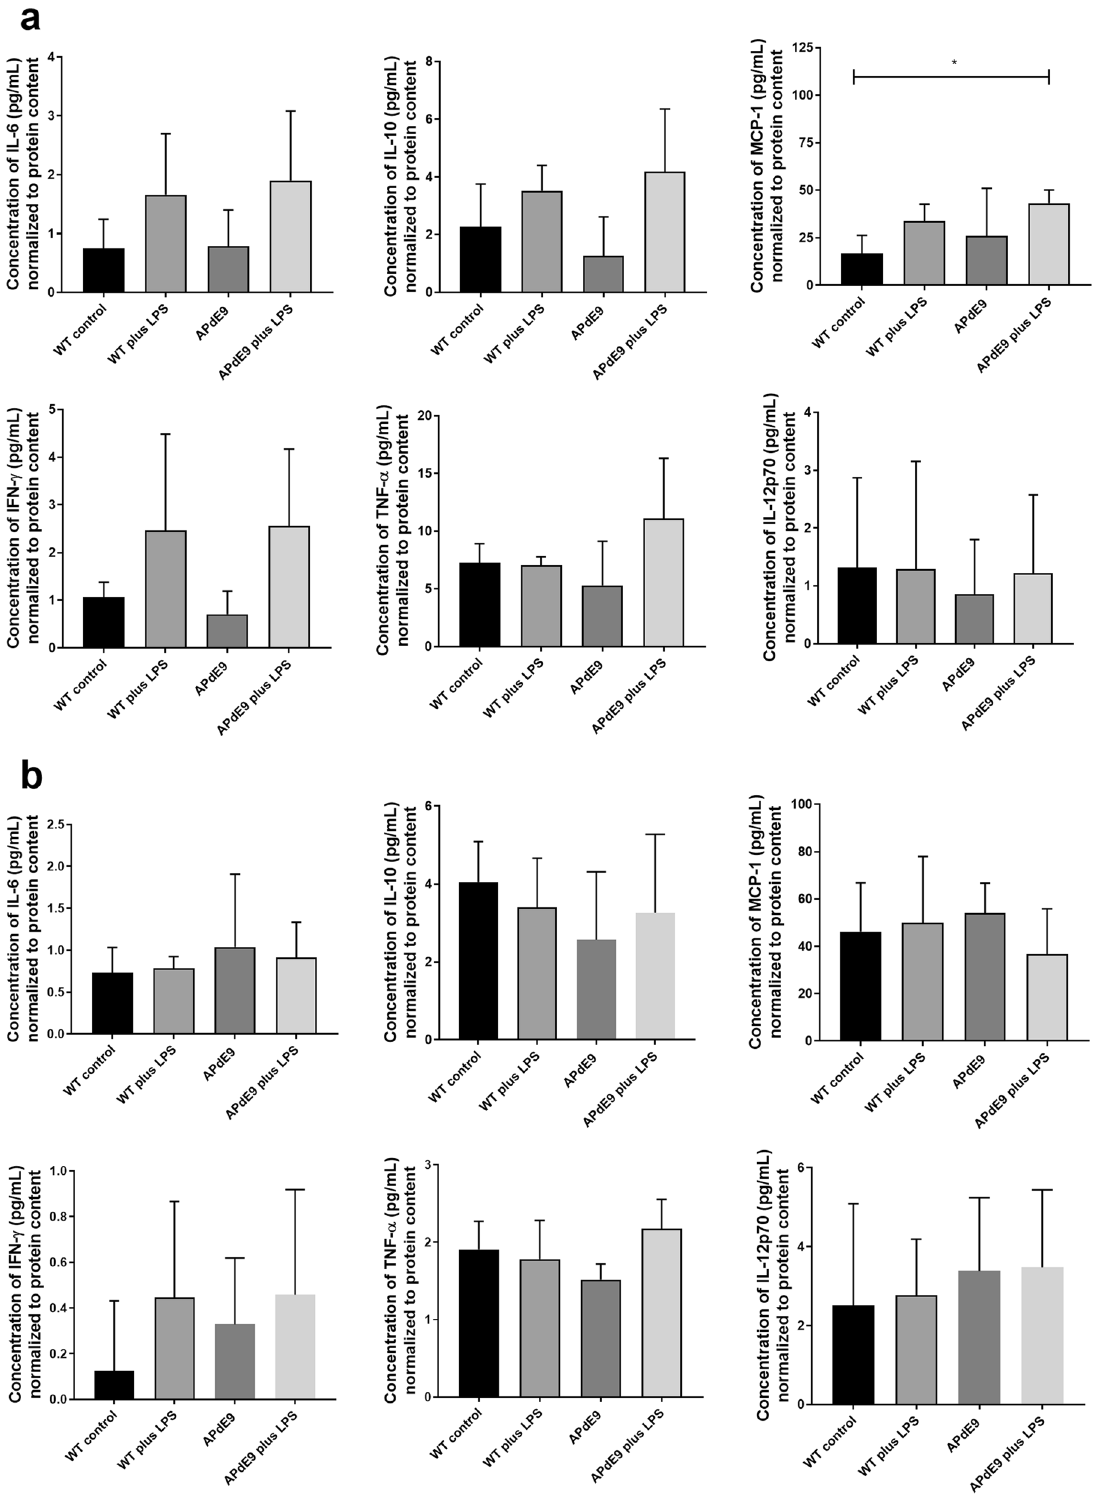
Figure 5. ( a ) The comparison of levels of interleukins (IL-6, IL-10, IL-12p70), interferon-γ (IFN-γ), monocyte chemoattractant protein-1 (MCP-1) and tumour necrosis factor α (TNF-α) in spleen of wild-type (WT) mice treated with LPS (n = 5), APdE9 mice with (n = 6) and without (n = 6) treatment with LPS versus WT control (n = 5). ( b ) The comparison of levels of IL-6, IL-10, MCP-1, IFN-γ, TNF-α and IL-12p70 in plasma of wild-type (WT) mice treated with LPS (n = 5), APdE9 mice with (n = 6) and without (n = 6) treatment with LPS versus WT control (n = 5). The data is presented as mean ± SD. Asterisks denote a statistically significant difference from the respective control (* p < 0.05, one-way ANOVA followed by Dunnett’s multiple comparisons